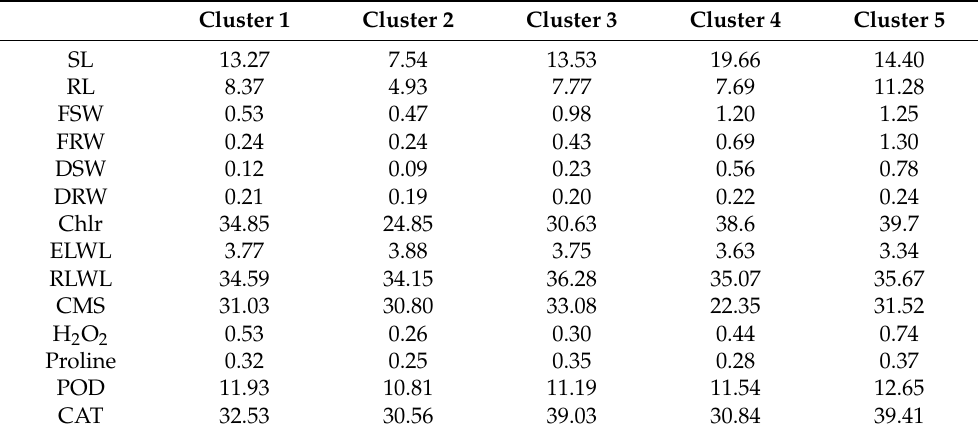
Table 6. K-means cluster analysis of 50 cotton genotypes grown under 50% drought level.